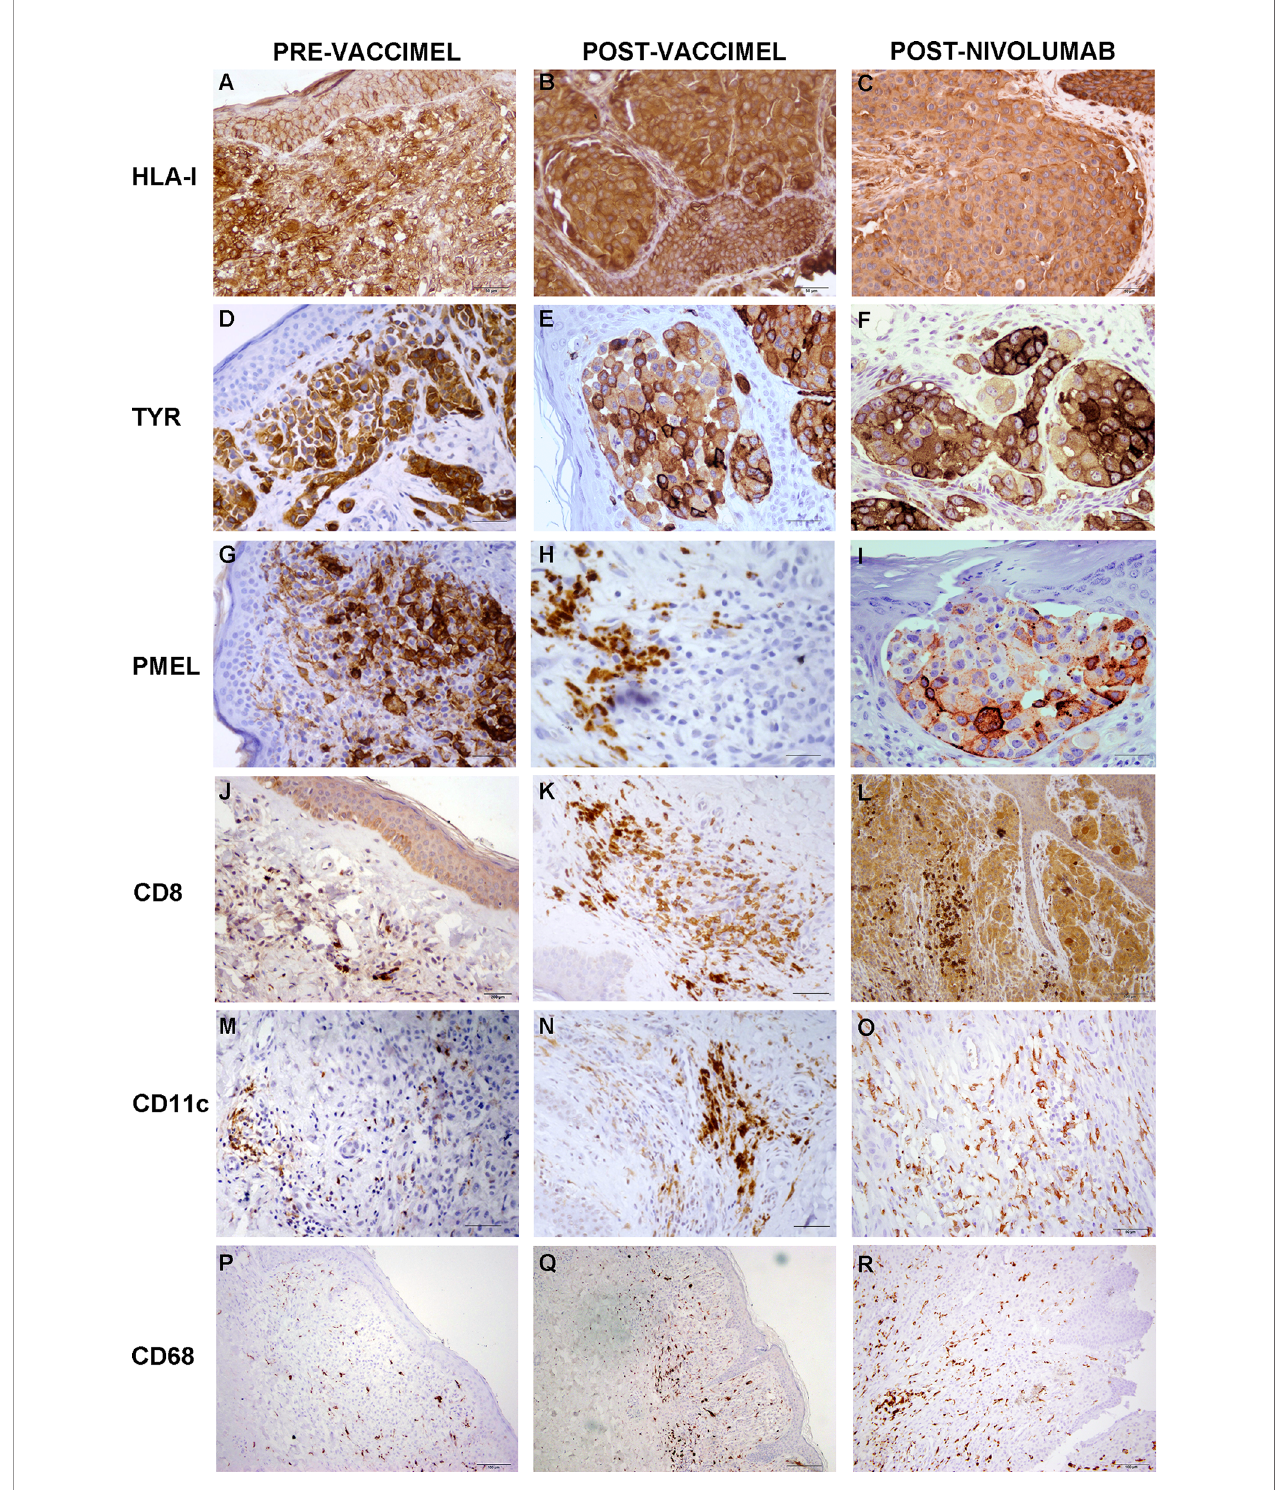
FIGURE 4 | Comparative analysis of Patient#5 ITM immune populations. Immunostaining was performed as described under Methods on ITM biopsies obtained before VACCIMEL immunization, after VACCIMEL immunization, and following nivolumab treatment: (A – C) HLA class I; (D – F) TYR; (G – I) PMEL; (J – L) CD8; (M – O) CD11c; (P – R) CD68. Scale bars: (A – I) 50 µm; (J – O) 100 µm; (P – R) 200